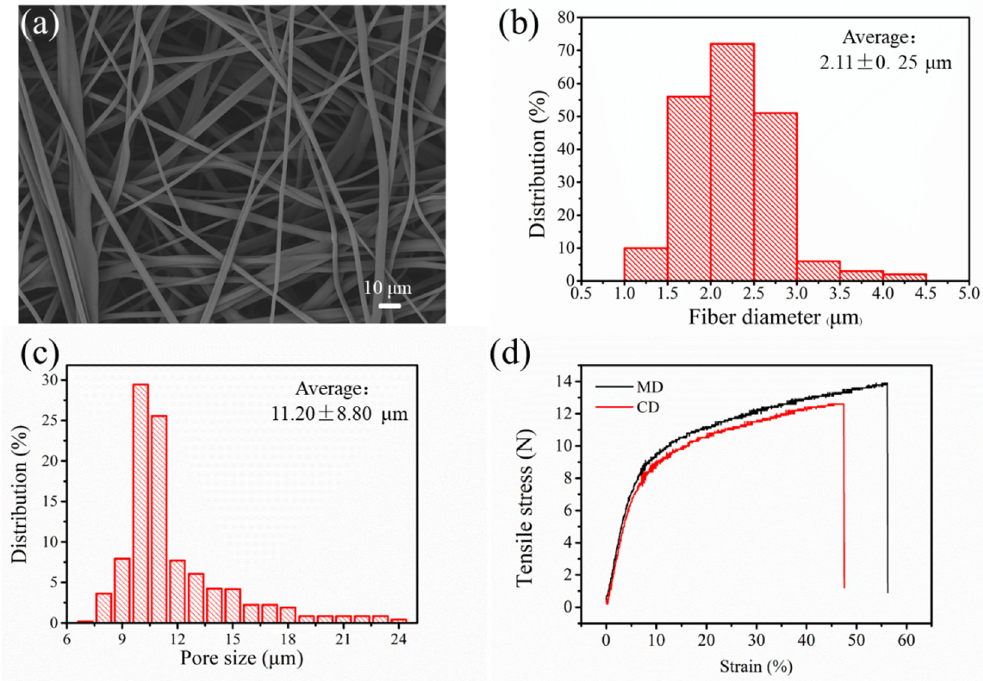
Figure 2. Web properties of melt blown nonwovens: ( a ) SEM image, ( b ) fiber diameter distribution, ( c ) pore size distribution, and ( d ) tensile strength .